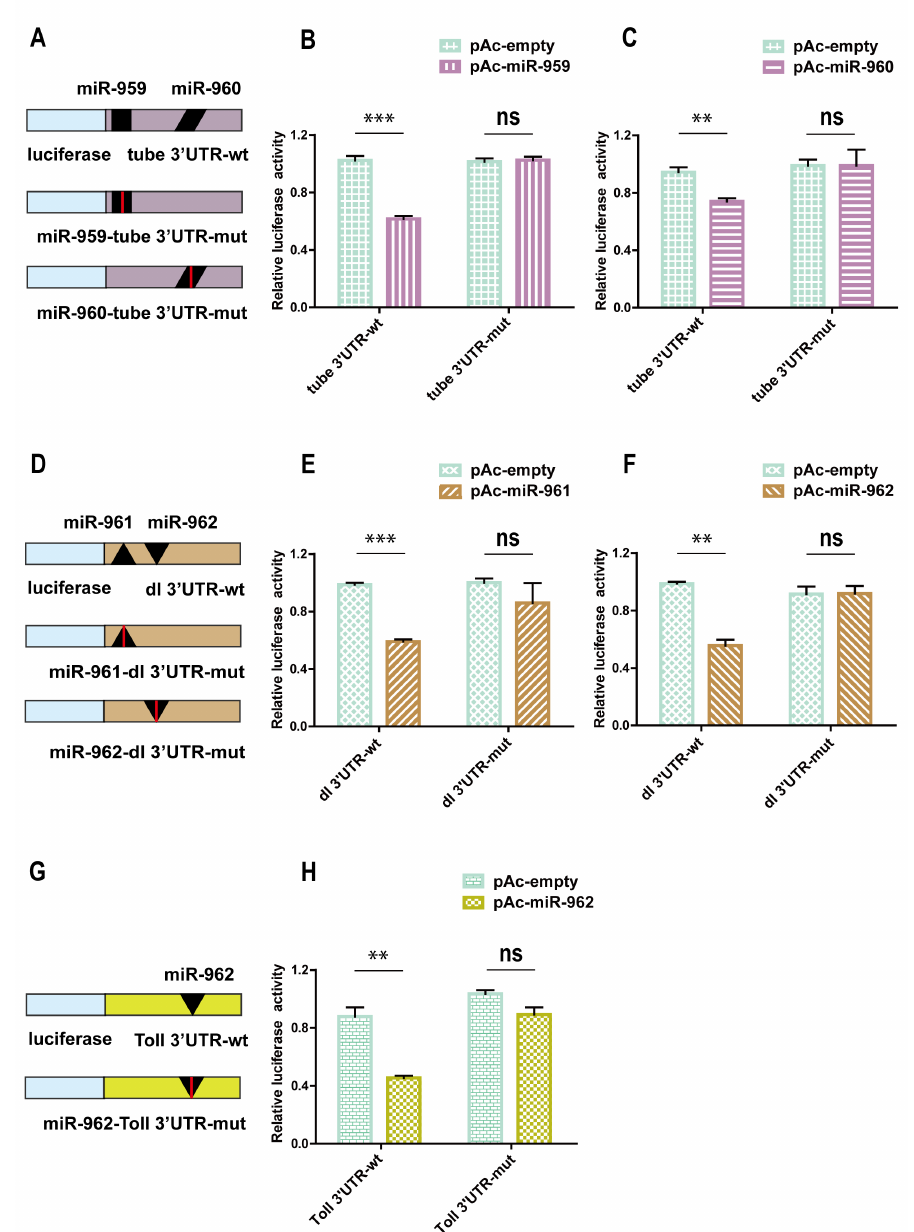
Figure 5. The direct bind between four miRNA members from miR-959–962 cluster and its target genes were confirmed by Dual luciferase reporter assay in vitro . ( A , D , G ) The schematic diagrams of construction of targets 3 (cid:48) UTR and 3 (cid:48) UTR mutation luciferase reporter plasmids were presented. After co-transfected with miRNA expression plasmid, the corresponding luciferase activity of the report plasmids without or with mutation sites was determined in Drosophila S2 cell on a Dual luciferase assay ( B , C , E , F , H ). (** p < 0.01; *** p < 0.001; and ns, no significance vs. the